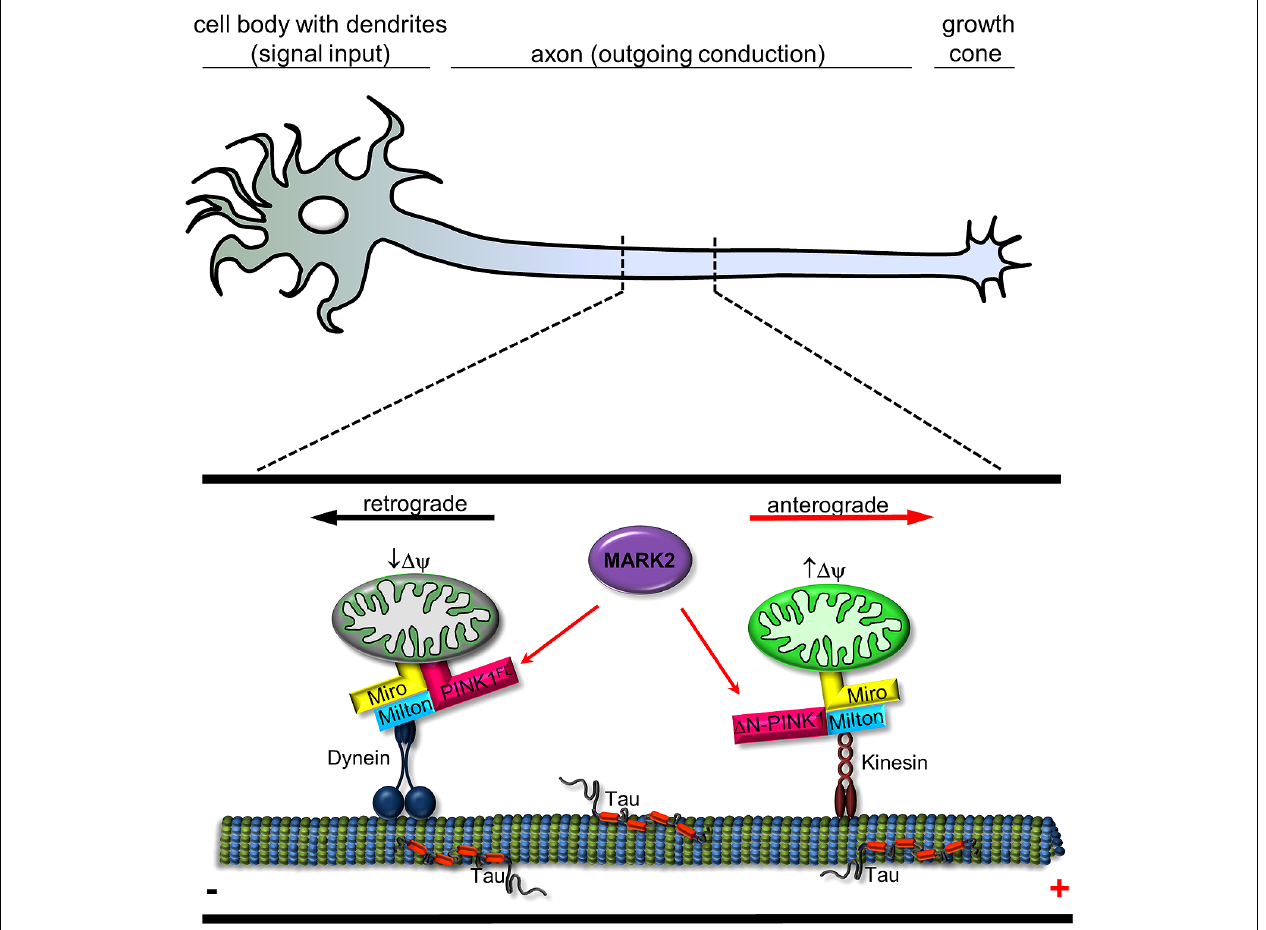
and regulate in association with (cid:2) N-PINK1 the anterograde movement ( red arrow ; Matenia etal., 2012; Dagda etal., 2013), whereas Miro also has an effect on dynein-mediated retrograde movement (Russo etal., 2009; black arrow ). Active mitochondria tend to cause cleavage of PINK1 FL (Narendra etal., 2010), which is phosphorylated atThr-313 by MARK2 (Matenia etal., 2012); both events promote anterograde movement by kinesin. Retrograde movement by dynein is promoted by PINK1 FL and further increased by MARK2 (Matenia etal.,